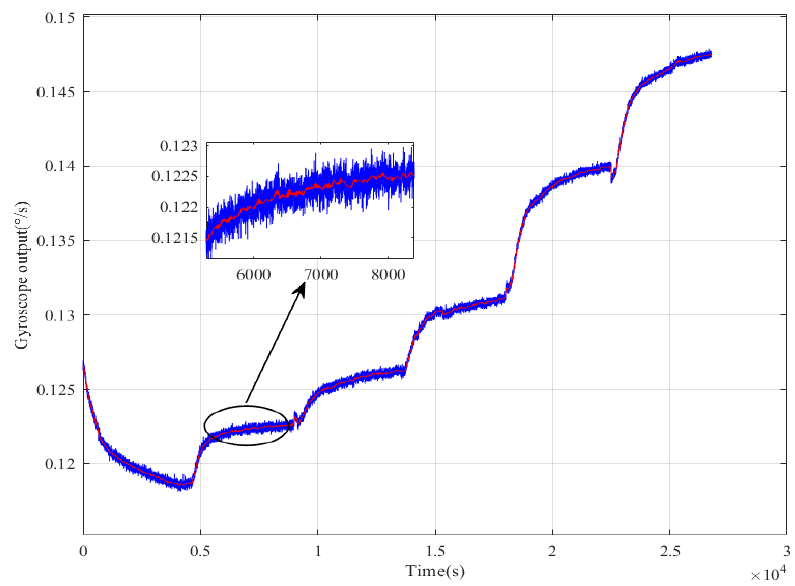
Figure 15. The comparison of gyroscope output signals before and after denoising.